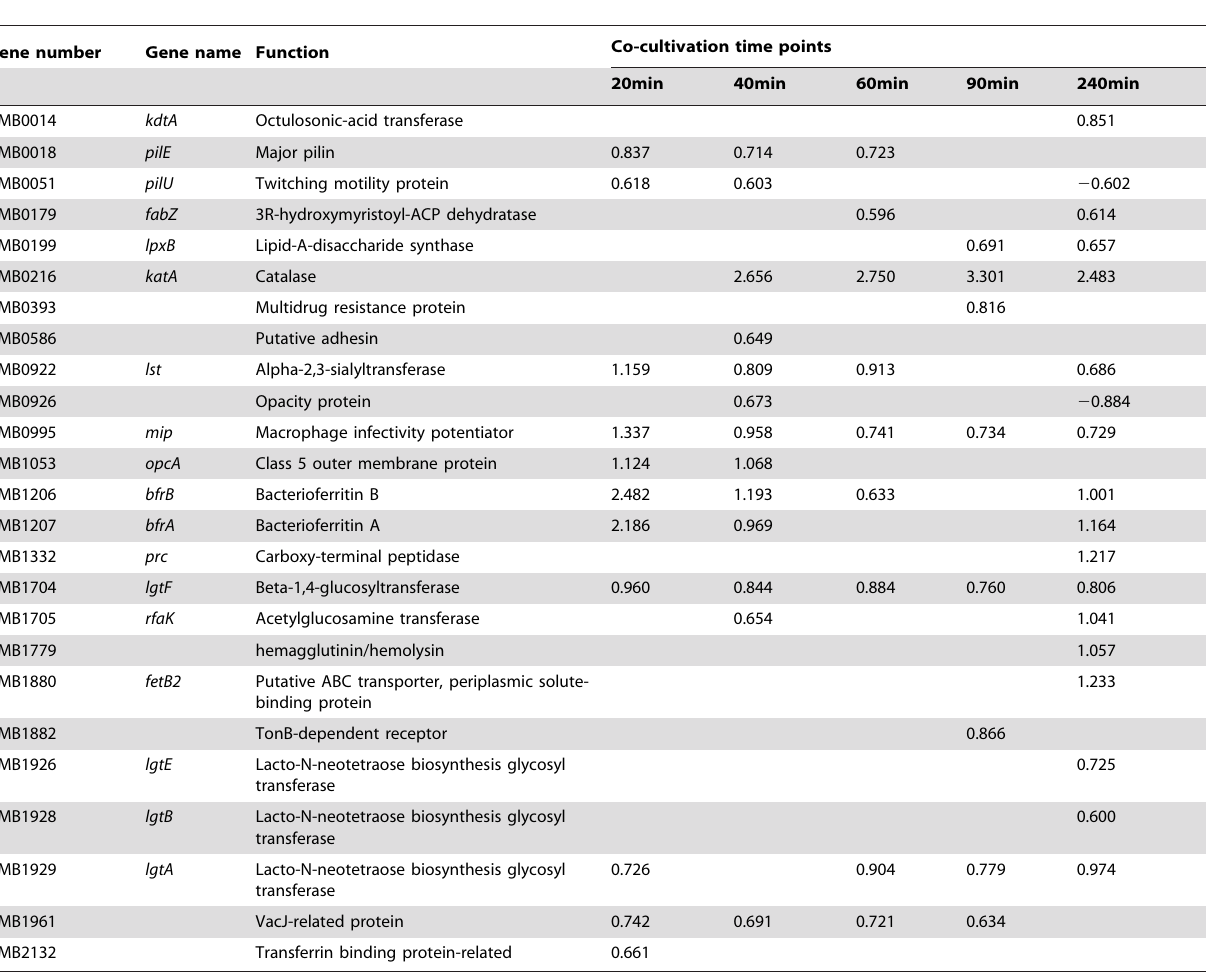
Table 3. Differentially expressed meningococcal genes encoding virulence factors* during blood co-cultivation compared with T=0min samples (log 2 ratio, p , 0.01 with FDR).